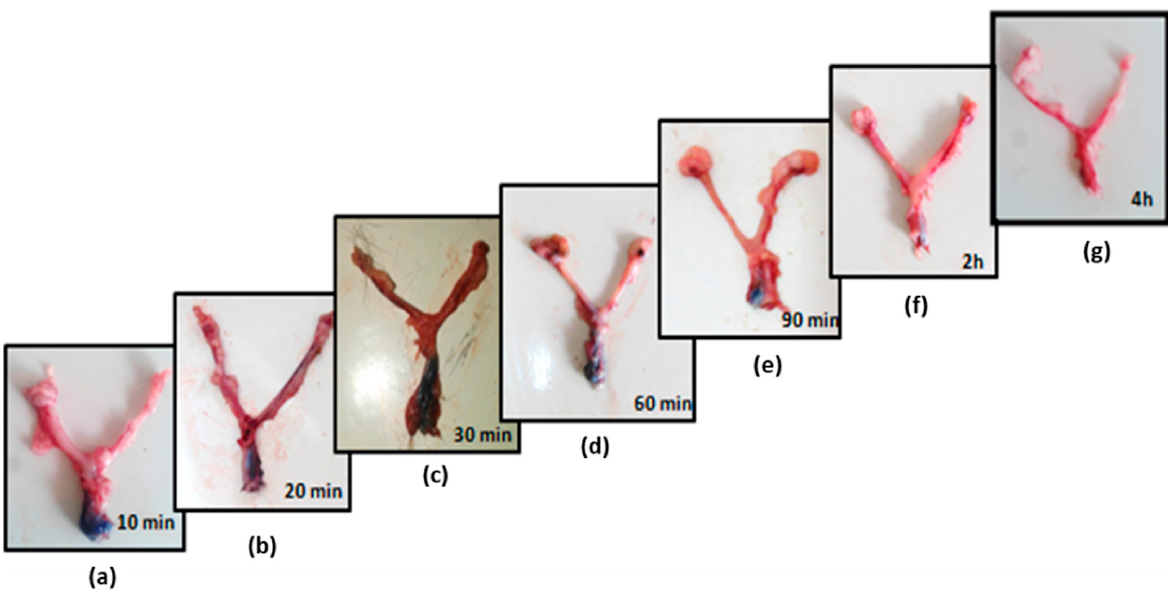
Figure 8. In vivo retention of trypan-blue-labeled suppositories observed at different time points (from ( a ) at 10 min to ( g ) at 4 h) in the dissected vaginal cavity of rats. High-intensity blue color marks the presence of suppository and fading blue color (from 60 min onwards) marks the dissolu- tion/melting of the suppository at the vaginal site. Table 5. Scoring of in vivo retention of formulated suppositories. Time